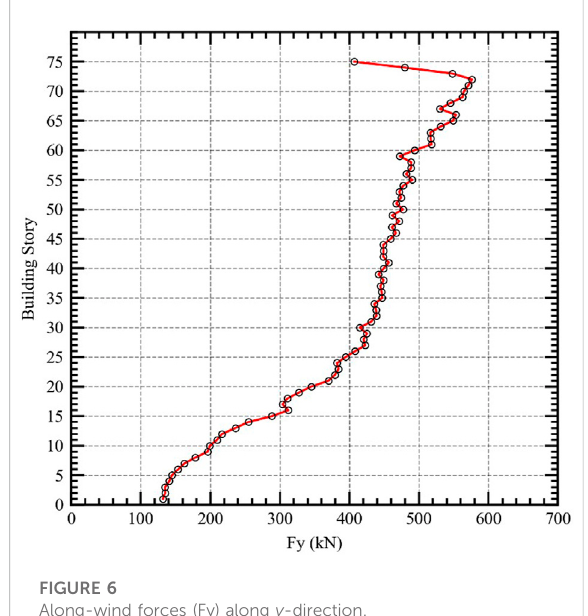
FIGURE 6 Along-wind forces (Fy) along y